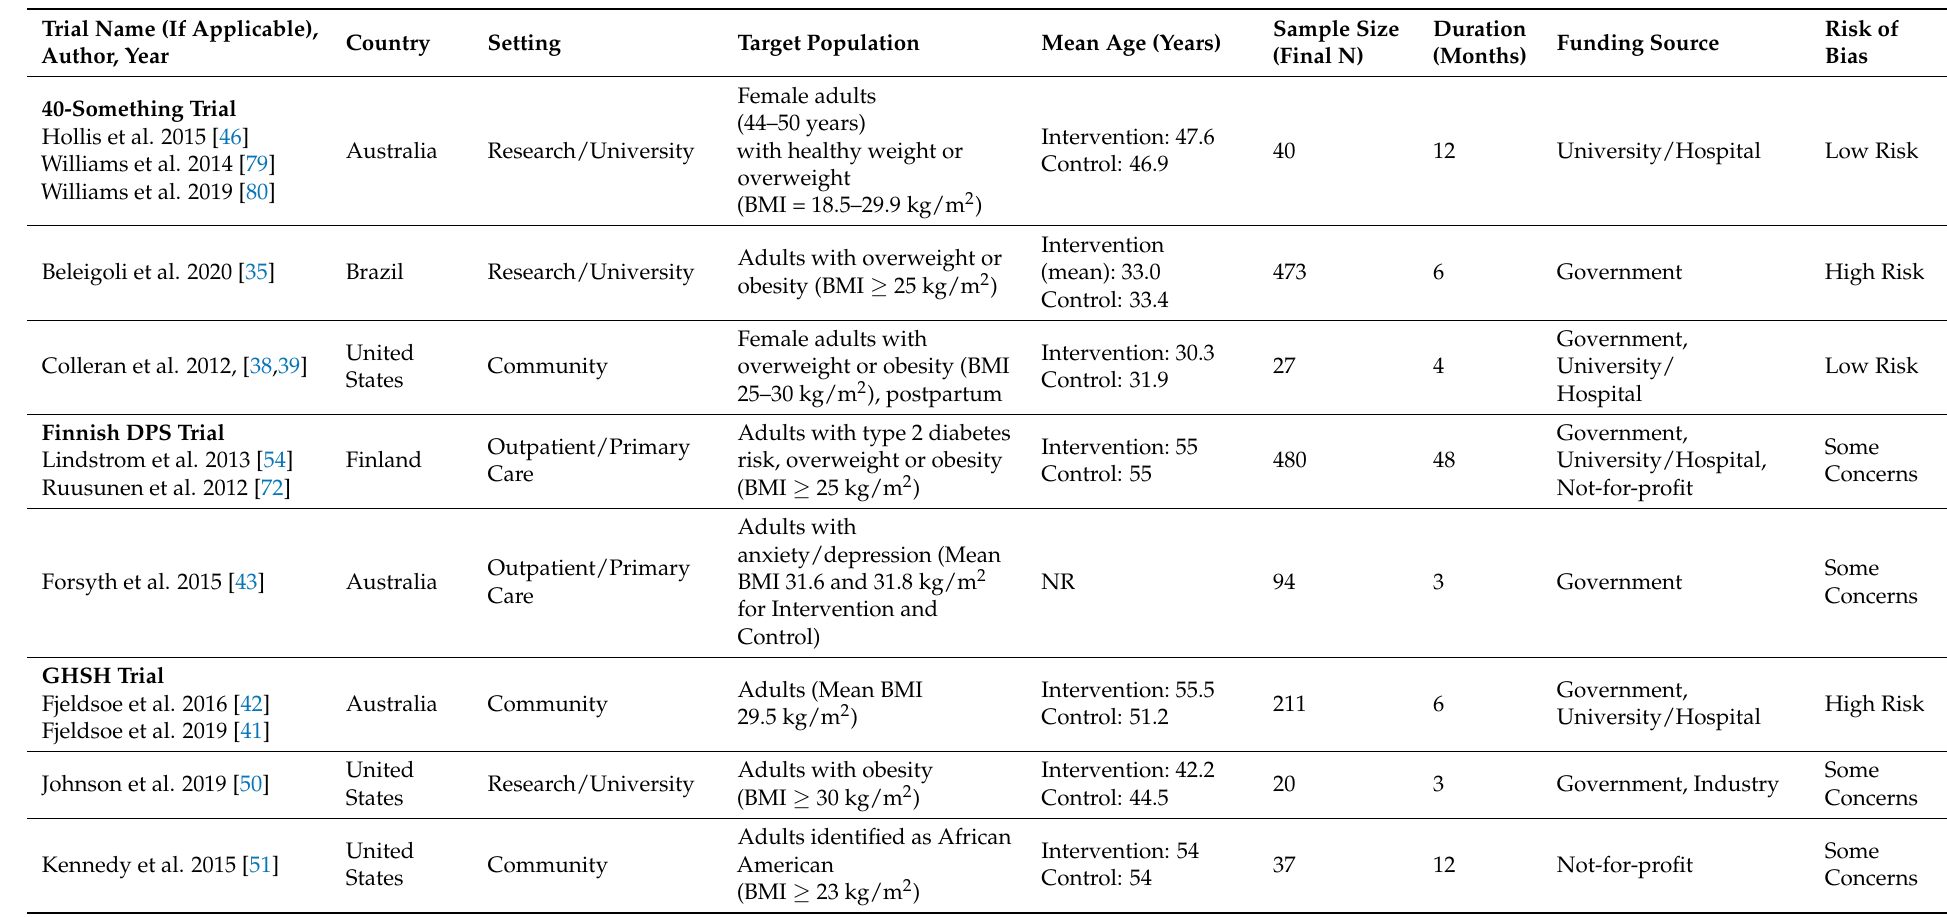
Table 2. Study characteristics of randomized controlled trials included in the systematic review examining effect of nutrition and physical activity interventions provided by nutrition and exercise practitioners for the general